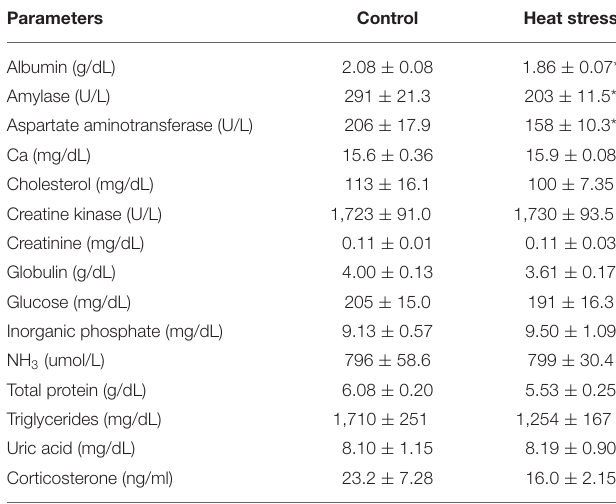
TABLE 1 | Effects of a moderate increase in temperature-humidity index (THI) on blood biochemicals in laying